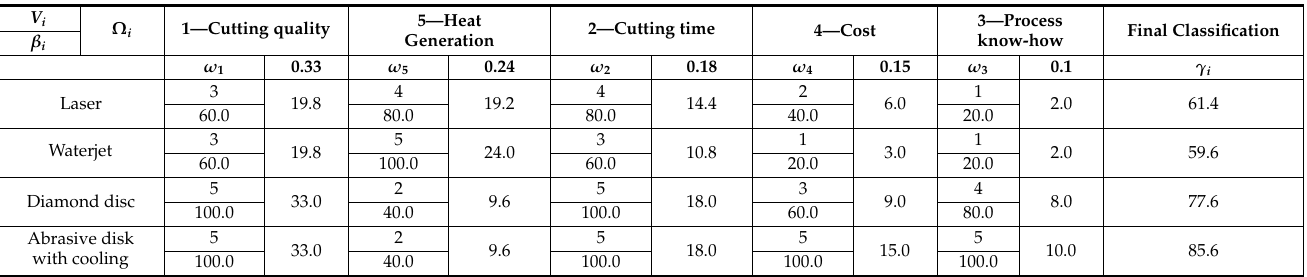
Table 1. Selection matrix for the choice of spiral cutting